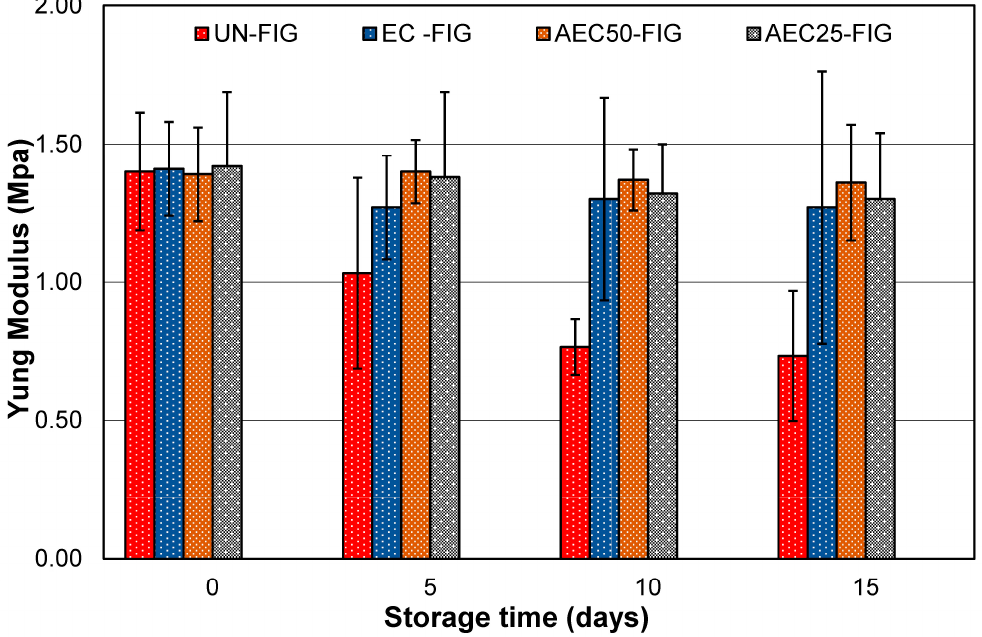
Figure 3. Compression tests of fig fruits during storage at 4 °C for 15 days for all different preservation